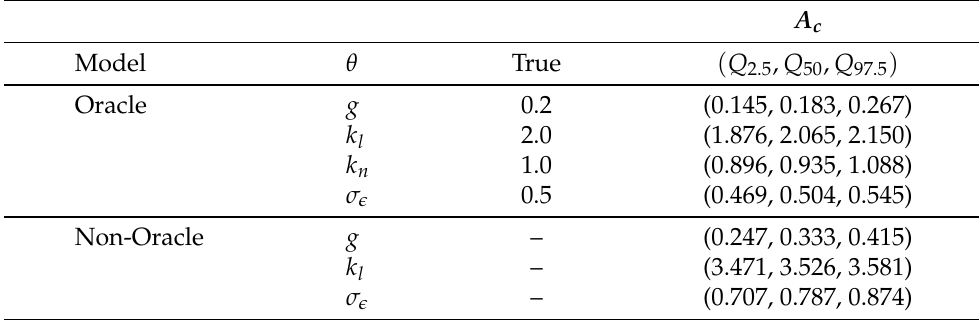
Table 1. Parameter estimates given by approximately 95% credible intervals, ( Q 2.5 , Q 50 , Q 97.5 ) , for both Oracle and non-Oracle models using simulated forcing data with A c = 5, σ (cid:101) = 0.5. Based on 10,000 posterior